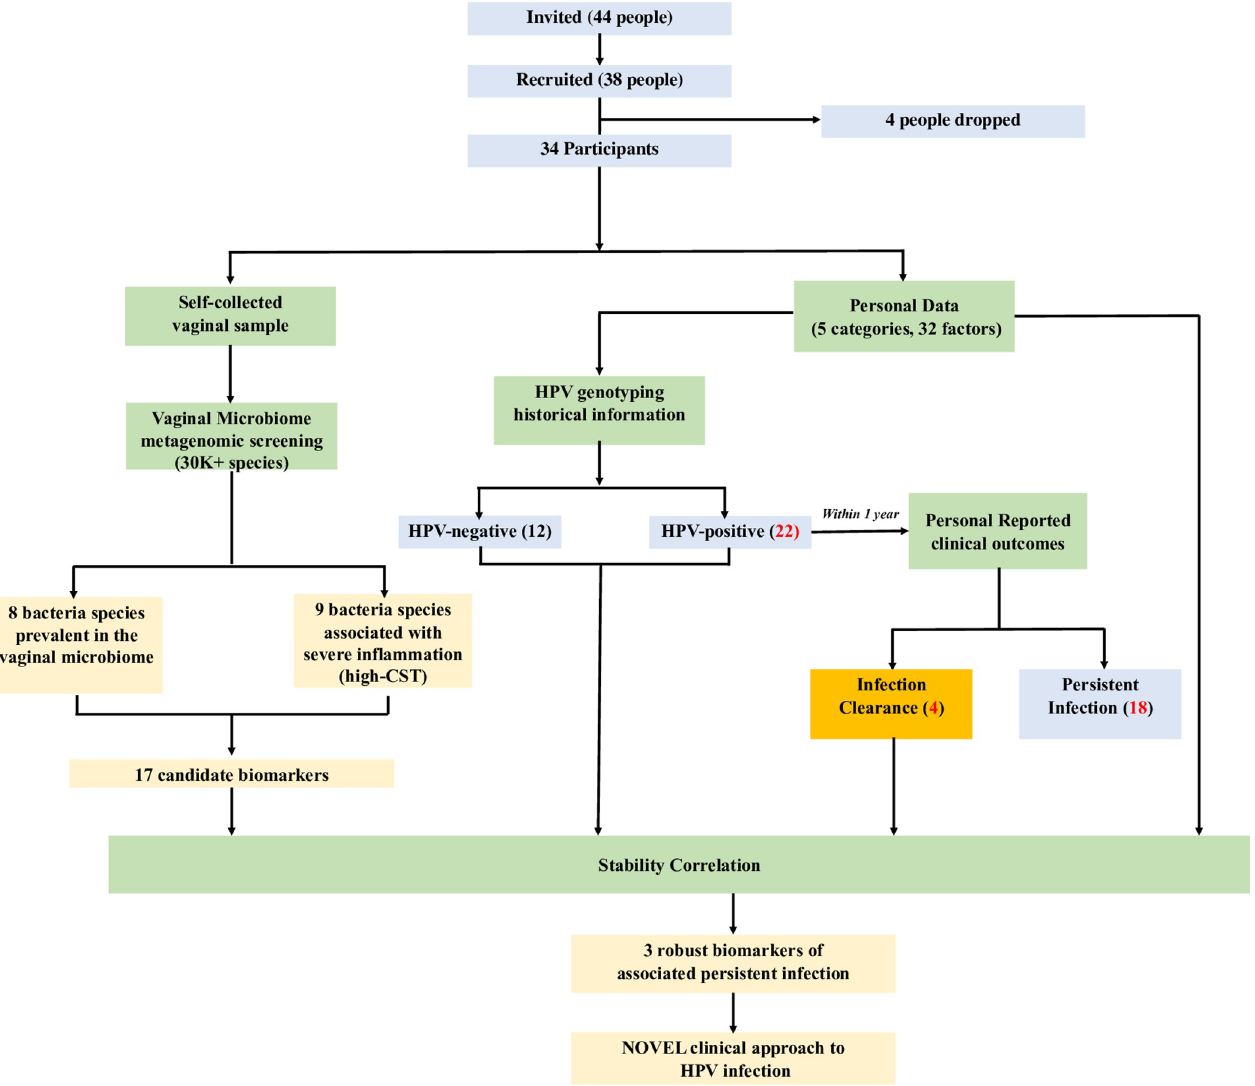
Fig 1. Flowchart for identifying biomarkers between vaginal microbiota and HPV status. 30K = 30,000; HPV = Human papillomavirus; CST = community state type.